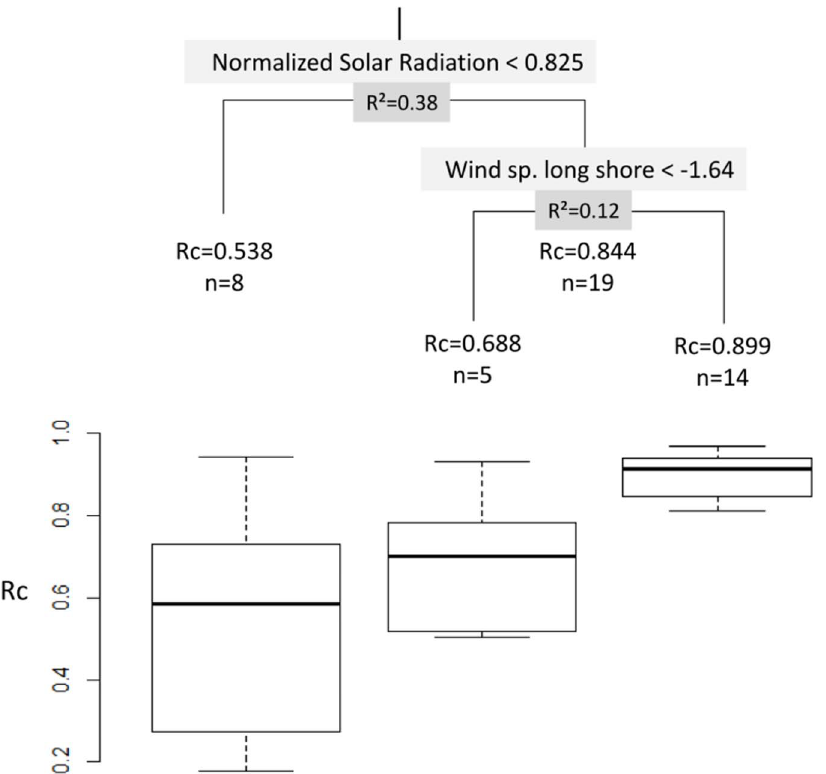
Figure 5. Environmental factors explaining the variation in the directionality (R c ) of Premnasbiaculeatus . Regression tree of swimming directionality of 28 P. biaculeatus post-larvae, with box plots showing the distribution of R c in each terminal node.